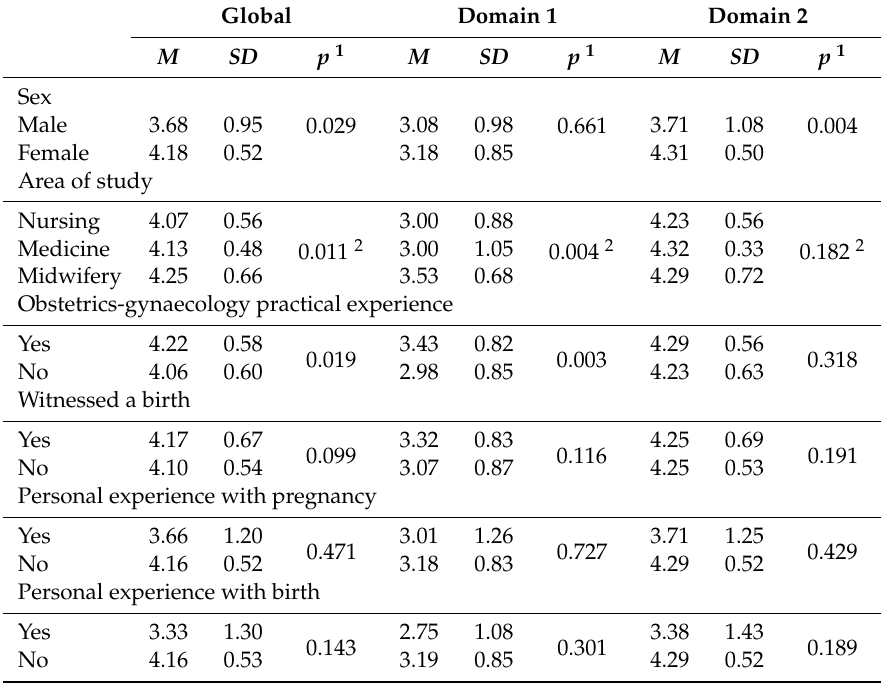
Table 3. Descriptive and comparative results of the sociodemographic variables and PercOV-S. Global